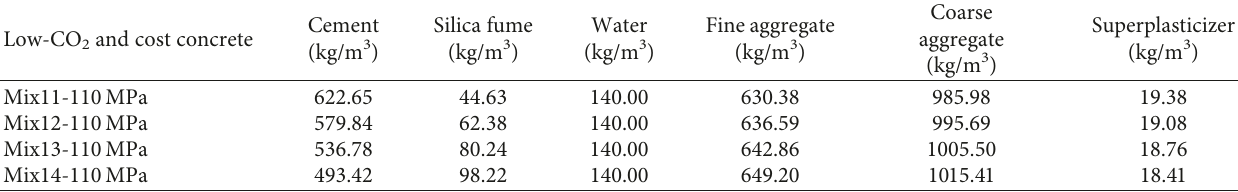
2 emissions of low-cost 2 emissions and lower cost.